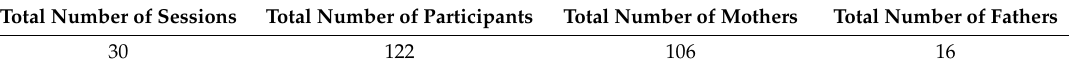
Table 1. Basic features of the music therapy self-care group since its implementation in July 2018 to November